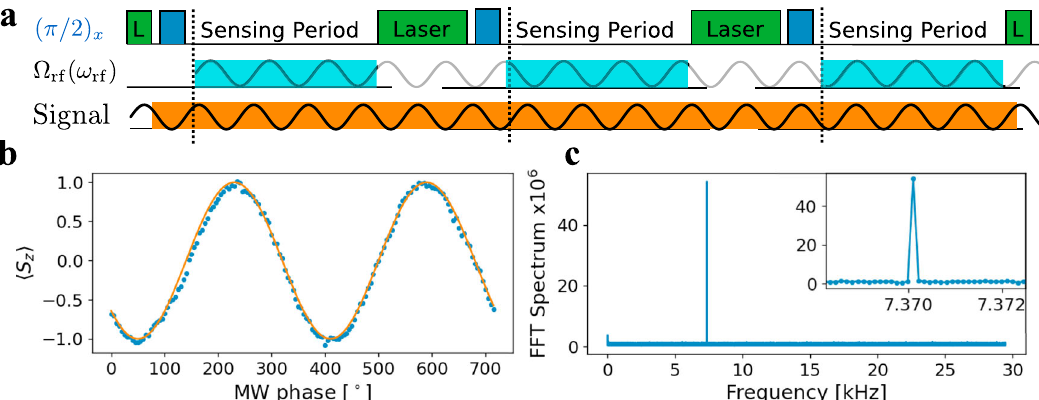
Fig. 5 Heterodyne detection using Floquet dressed states. a Experimental scheme: Optical initialization and readout of the electron spin (green), preparation of the rotating frame by a π /2 pulse (blue). In addition, a RF fi eld is applied for the sensing period (light blue), which is coherent between measurements. The demodulation frequency between a MW signal (orange) and the reference is given by Δ ω − ω rf for the fi rst sideband. b Sensor response as a function of the signal phase in the Floquet dressed system, while the RF phase is fi xed. c Heterodyne detection of the MW- fi eld in a series of 10 6 coherent measurements in the Floquet dressed system. The phase of the RF fi eld is modulated by ϕ i + 1 = ϕ i + 45°, giving maximal sensor response ( Δ ω = ω rf ) while moving the signal frequency to ν demod. = 1/8 of the sampling frequency.